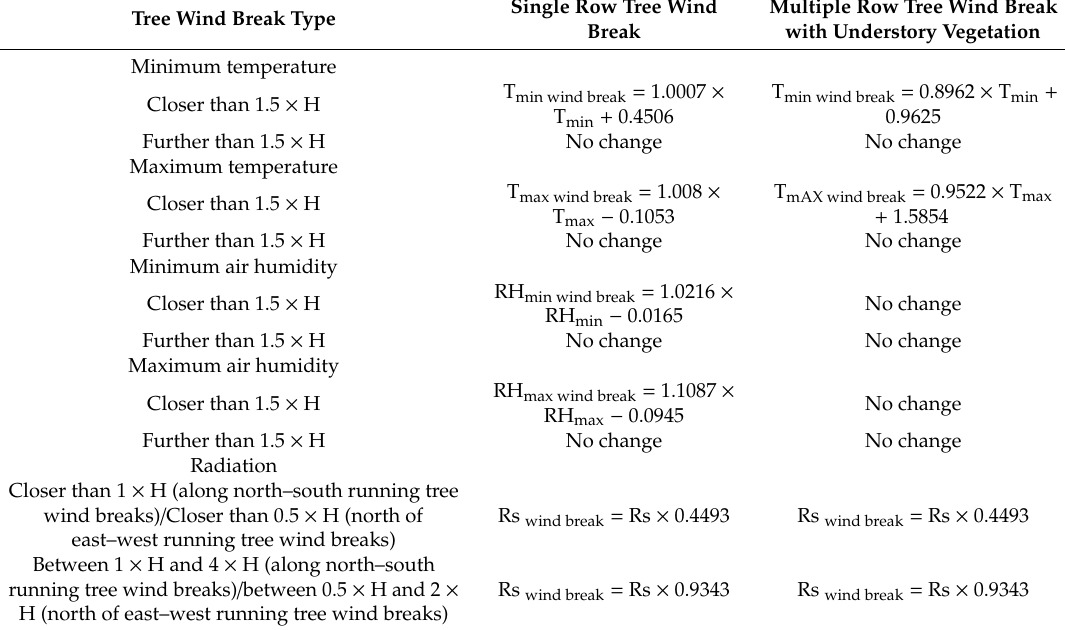
Figure 10. Radiation of open field conditions (Rs open field ) versus radiation (Rs wind break ) leeward of the single row tree wind break at the following distances from the tree wind break: 0.5 * H (in subgraph A ) and 2 * H (in subgraph B ). Distances are expressed in multiples of wind break tree height (H). Measurement time was from 19 April to 3 May. Table 4. Changes of temperature (T [ ◦ C]), air humidity (RH), and solar radiation (Rs [MJ / d*m 2 ]) under impact of tree wind breaks. H refers to the height of the tree wind break. T min , T max , RH min , and RH max refer to daily temperature and humidity minima and maxima, respectively, as used for the ETo calculations following the procedure of [20]. Rs is the daily sum of solar radiation. T min wind break , T max wind break , RH min wind break , RH max wind break and Rs wind break refer to daily temperature and humidity minima and maxima, respectively, as well as the solar radiation as changed by the impact of tree wind breaks.